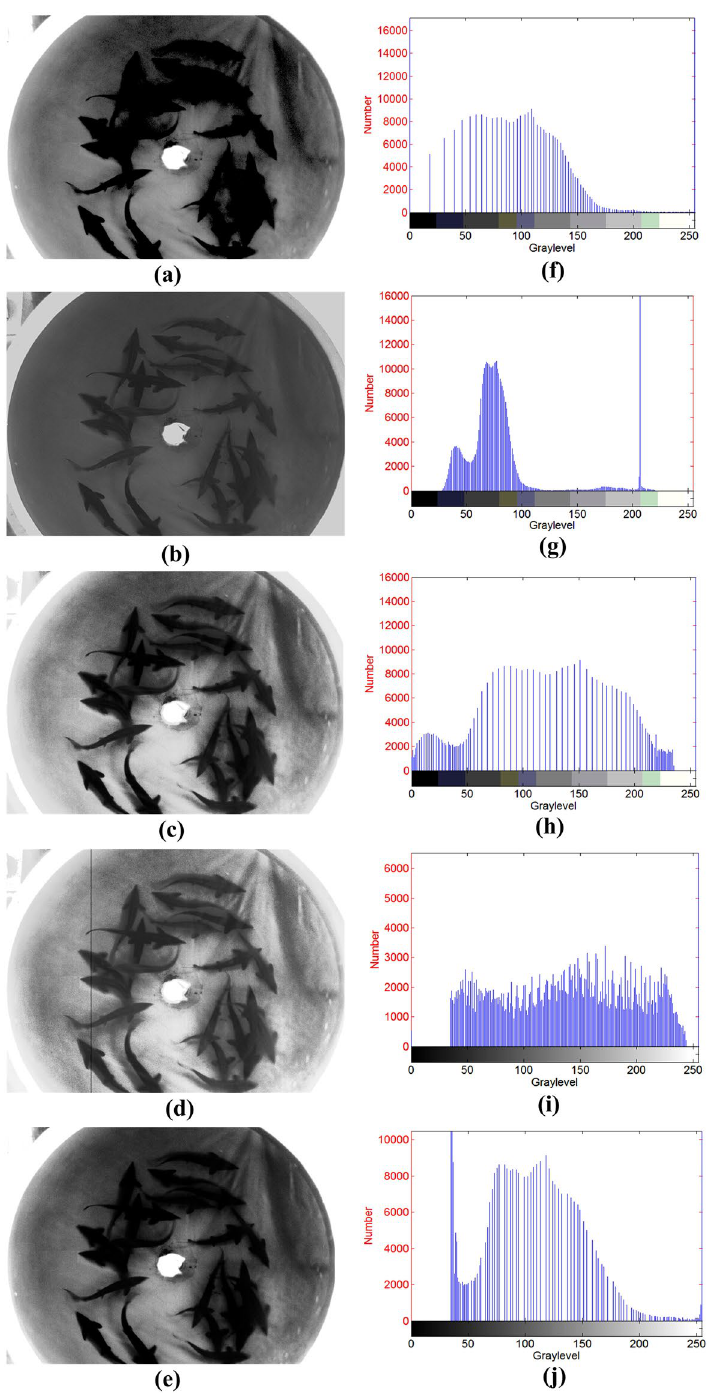
Figure 6. Results of other enhancement methods: ( a ) LE; ( b ) WT; ( c ) HE; ( d )CLAHE; ( e )GA-based;( f ) histogram of Fig. 6a; ( g ) histogram of Fig. 6b; ( h ) histogram of Fig. 6c; ( i ) histogram of Fig. 6d; ( j ) histogram of Fig.